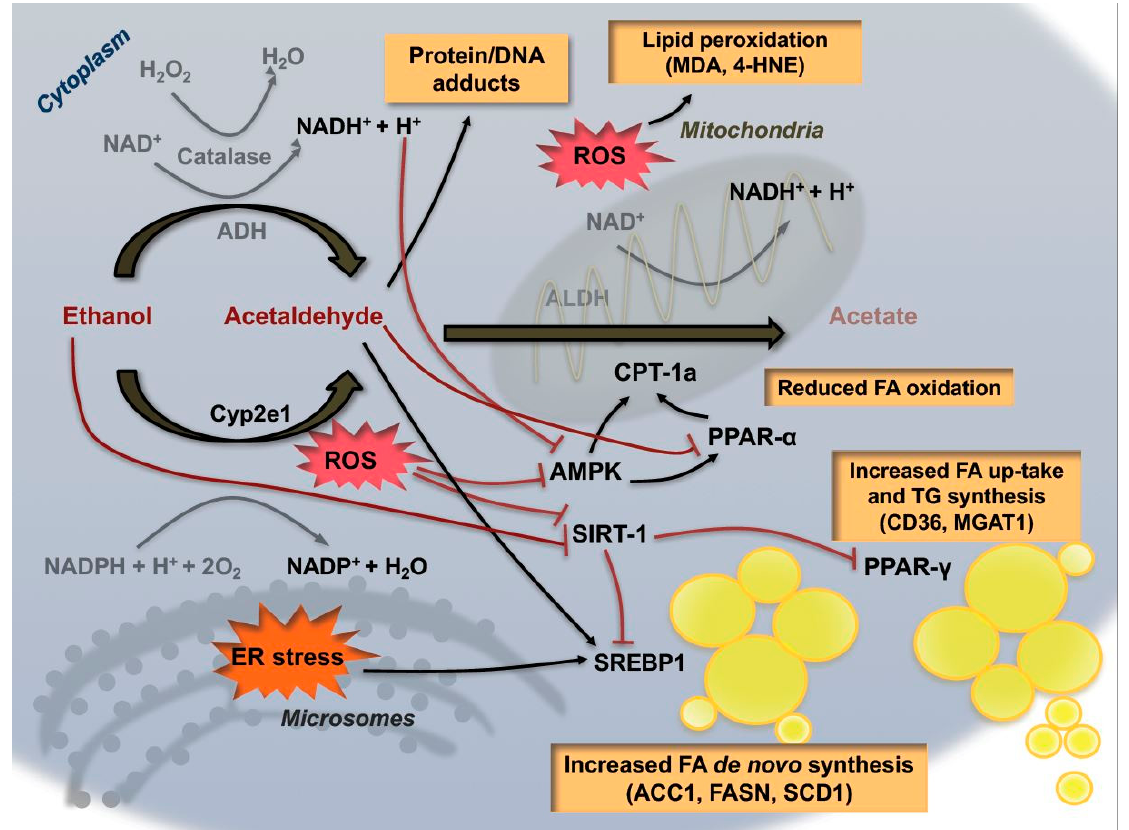
Figure 2. Metabolic effects of alcohol exposure on hepatocytes. Ethanol consumption directly and indirectly enhances lipid accumulation in hepatocytes via promoting the transcriptional activity of SREBP-1 and PPAR- γ . Acetaldehyde and ER stress also contribute to steatosis by inducing SREBP-1 activity and inhibiting PPAR- α expression. Moreover, alcohol metabolism increases ROS production via induction of CYP2E1 and impairment of mitochondrial functionality. Acetaldehyde and ROS exerts cyto-toxicity through generation of protein/DNA adducts and lipid peroxidation. ACC1: Acetyl-CoA-carboxylase-1; FASN: Fatty acid synthase; SCD1: Stearoyl-CoA desaturase-1; CPT1a: